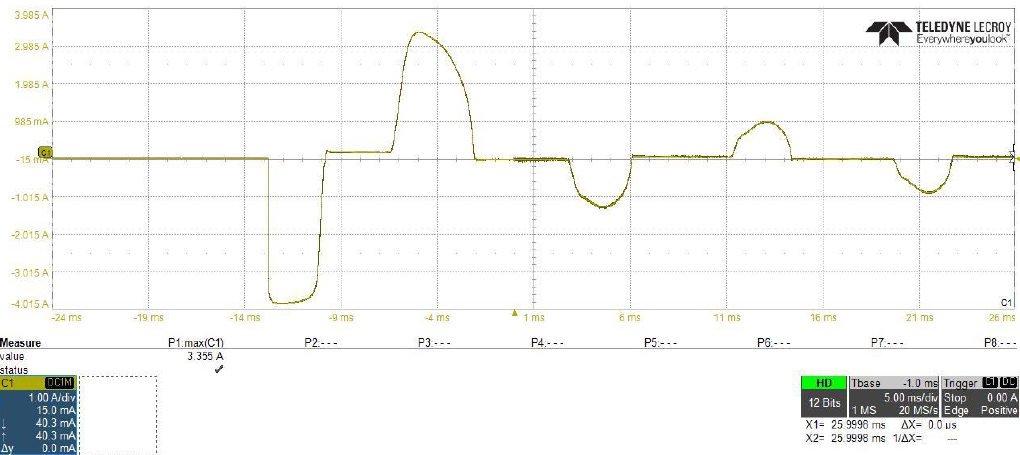
Figure 20. Power factor correction (PFC) converter stage AC input current without using of the proposed inrush current mitigation circuit. proposed inrush current mitigation circuit. Energies 2020 , 13 , x 18 of 24